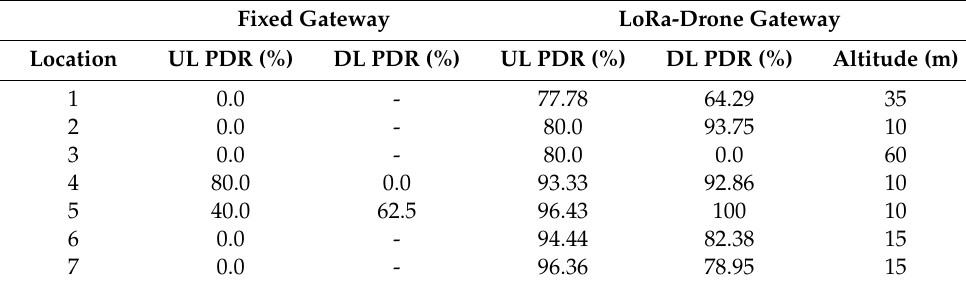
Table 2. PDR results for LoRa